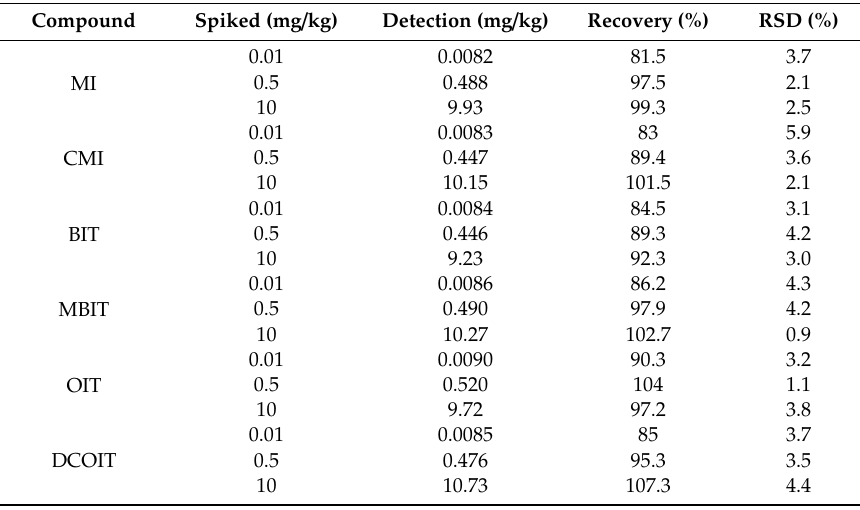
Table 2. The recovery and precision for six isothiazolinones spiked in three levels ( n = 6).